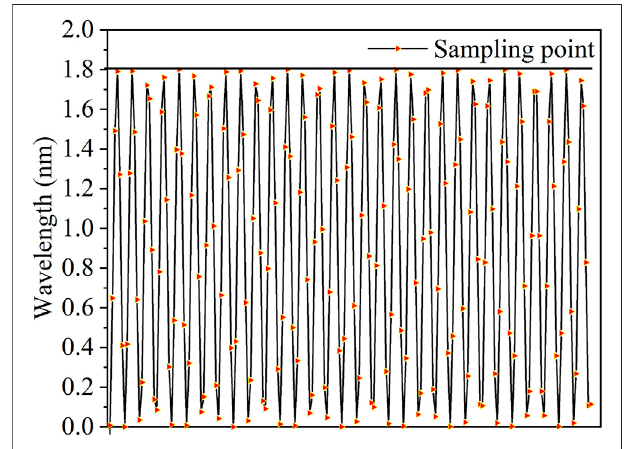
FIGURE 4 | Results of the reliability